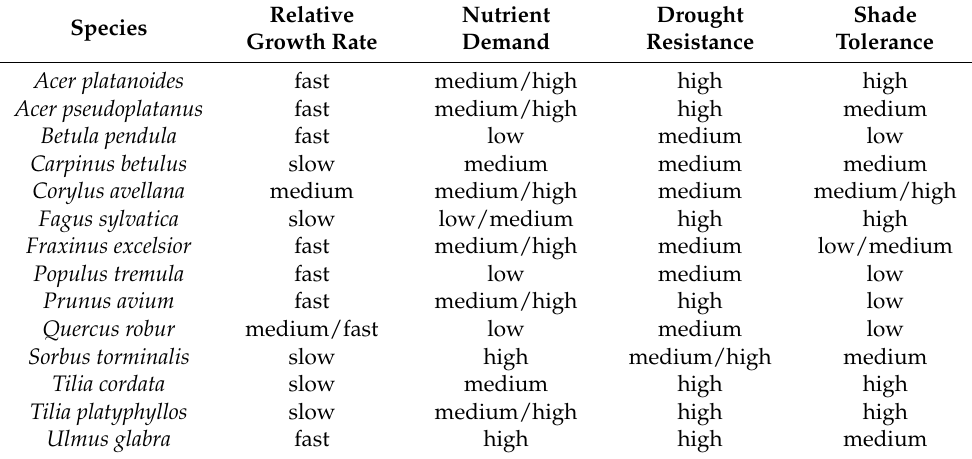
Table 1. Relative growth rates, nutrient demand, drought resistance, and shade tolerance of the investigated species. Details were taken from Kiermeier et al. [39] for Corylus avellana , for all other species from Professur für Waldbau und Professur für Forstschutz und Dendrologie der ETH Zürich [40]. Relative Nutrient Drought Shade Species Growth Rate Demand Resistance Tolerance Acer platanoides fast medium/high high high Acer pseudoplatanus fast medium/high high medium Betula pendula fast low medium low Carpinus betulus slow medium medium medium medium fast